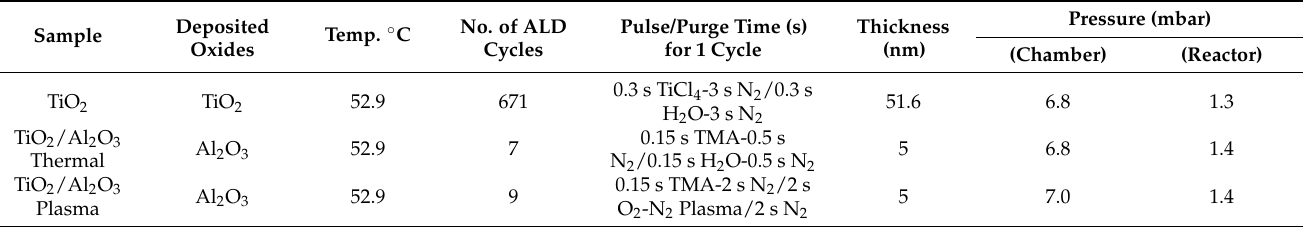
Table 1. TiO 2 and Al 2 O 3 thermal and plasma-assisted ALD deposition